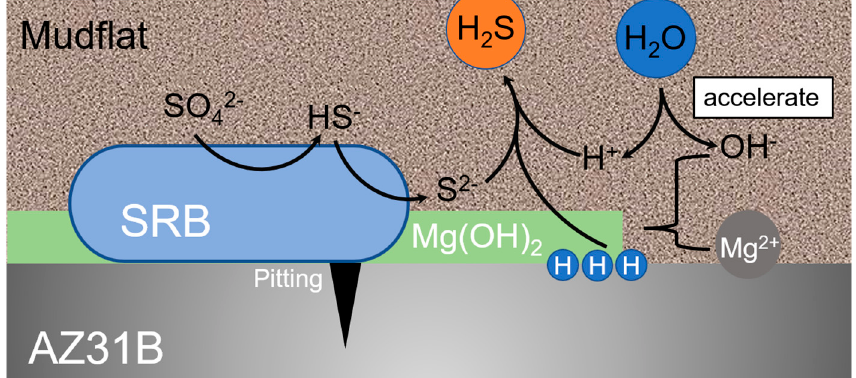
Figure 10. Schematic diagram of the mechanism, how SRP promote magnesium corrosion.